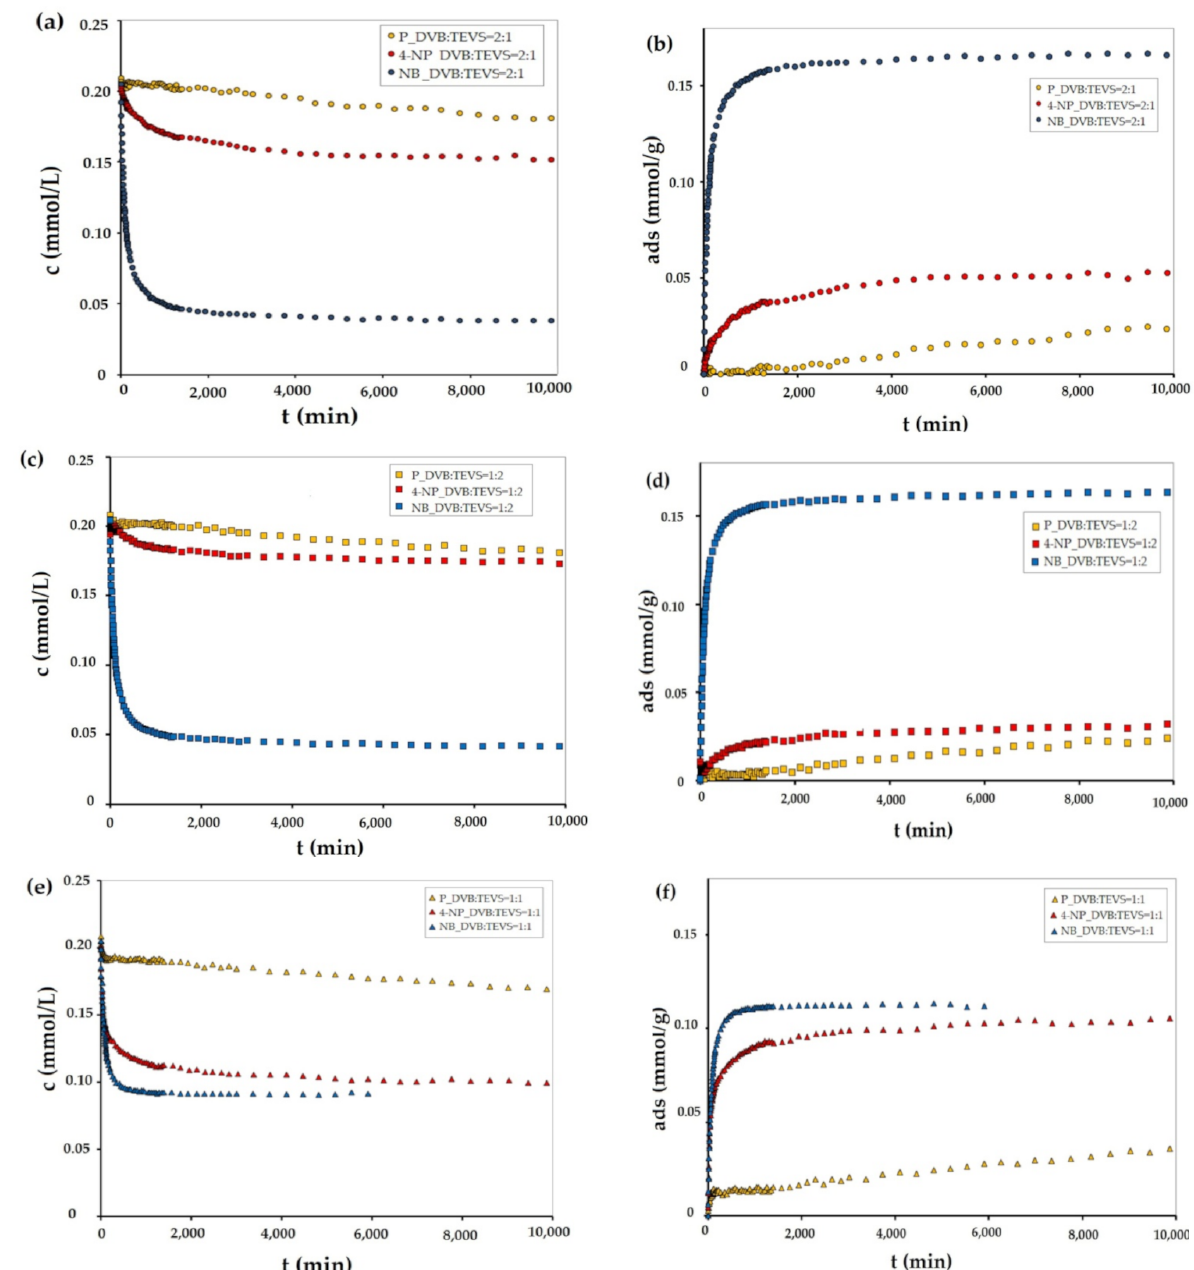
Figure 7. Adsorption kinetics for NB, P and 4-NP on DVB:TEVS = 2:1 ( a , b ), DVB:TEVS = 1:2 ( c , d ) and DVB:TEVS:1:1 ( e , f ) microspheres presented as changes in concentration over time and changes in adsorption over